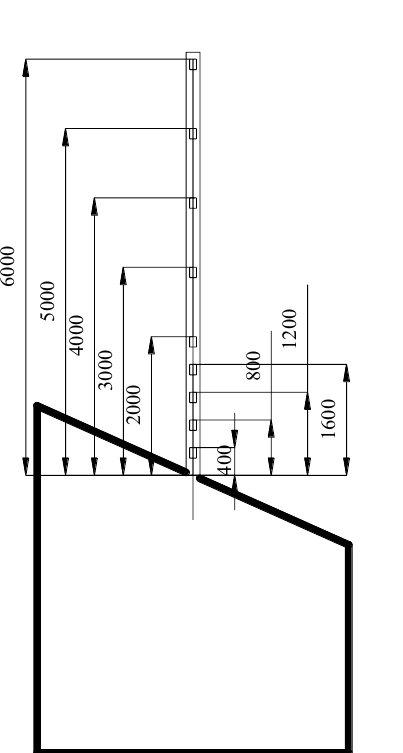
Figure 29. Layout of roadway surface displacement monitoring points.